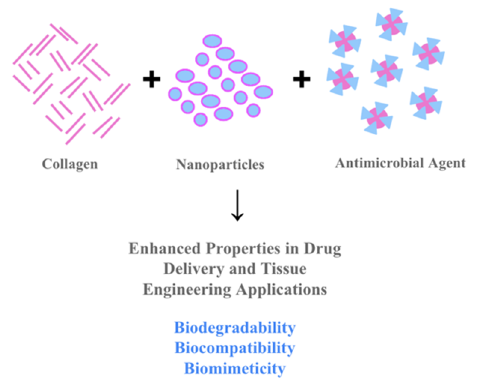
Figure 10. Enhanced properties of collagen NPs in DDS and TE.